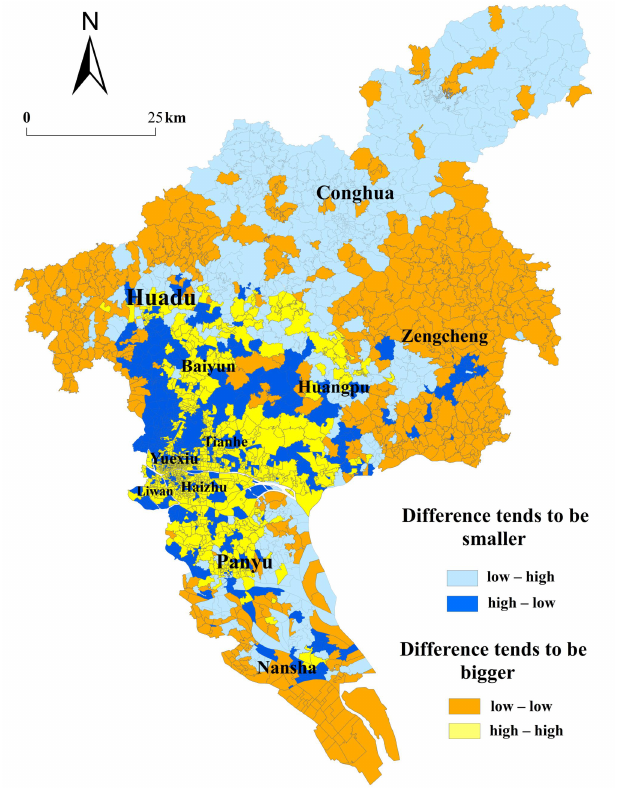
Figure 8. The distribution of the classification results of spatial equity by communities.